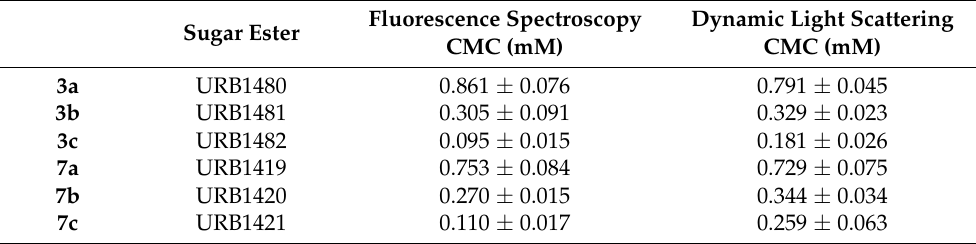
Figure 2. ( a ) Fluorescence intensity (peak I, III) vs. concentration plots for sucrose-based surfactants (URB1480-URB1482) and lactose-based surfactants (URB1419-URB1421). The values reported are the mean ± SD of three independent experiments. ( b ) Counts (kCps) vs. concentration plots from DLS measurements for sucrose-based surfactants (URB1480-URB1482) and lactose-based surfactants (URB1419-URB1421). The values reported are the mean ± SD of three independent experiments. Table 2. CMC values for sucrose-based surfactants (URB1480–URB1482) and lactose-based surfactants (URB1419–URB1421) as calculated from fluorescence and dynamic light scattering (DLS)